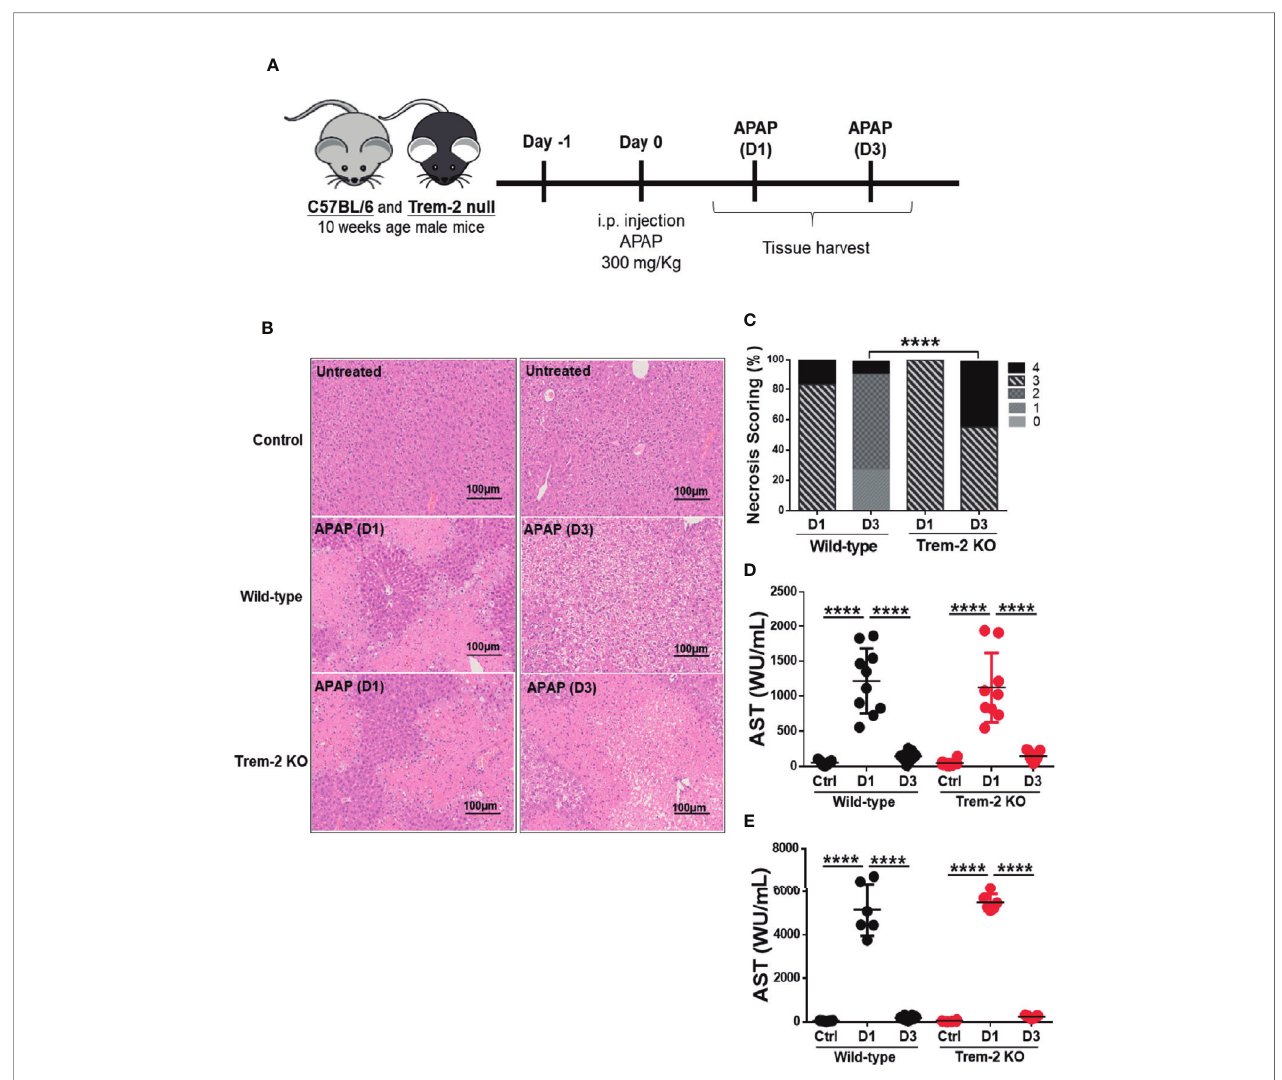
FIGURE 1 | Trem-2 KO mice show impaired recovery from liver damage induced by APAP. Acute liver damage induced by single intra-peritoneal administration of acetaminophen (APAP) was assessed 1 day (APAP-D1) or 3 days (APAP-D3) post-injection of wild-type and Trem-2 KO mice (A) . Hepatocyte necrosis was evaluated using hematoxylin-eosin staining (B) and scored from 0 to 4 according to location and extension of the necrotic lesions (C) . Liver damage was assessed by quanti fi cation of hepatic enzymes AST (D) and ALT (E) in the serum. Mean values and standard deviations are represented. Statistics: Chi-square test in necrosis scoring (C) ; One-way ANOVA in (D) ; (n=6-11 mice/group). ****,